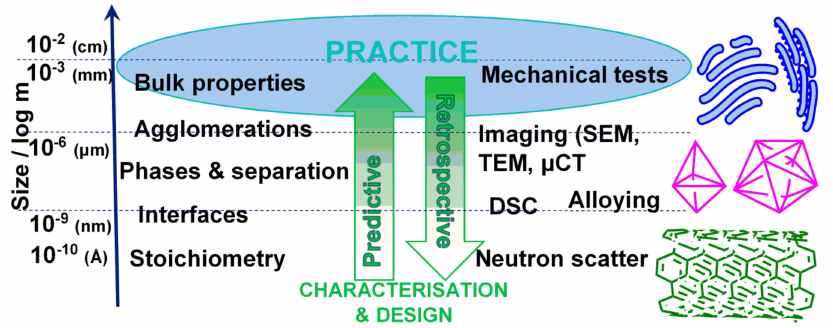
Figure 2. Schematic of structure-property-performance correlation, accessible through a combination of conventional and novel techniques encompassing nano- through meso- to macro-length scales of each parameter studied for general materials science and